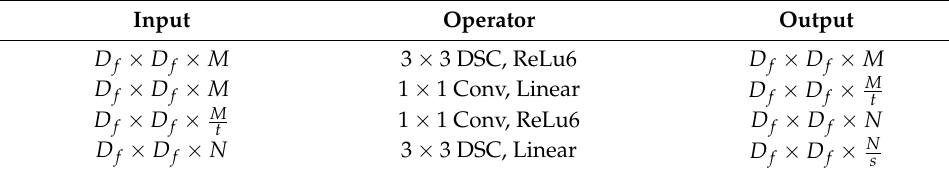
Table 2. The operation of the SandGlass-L block.